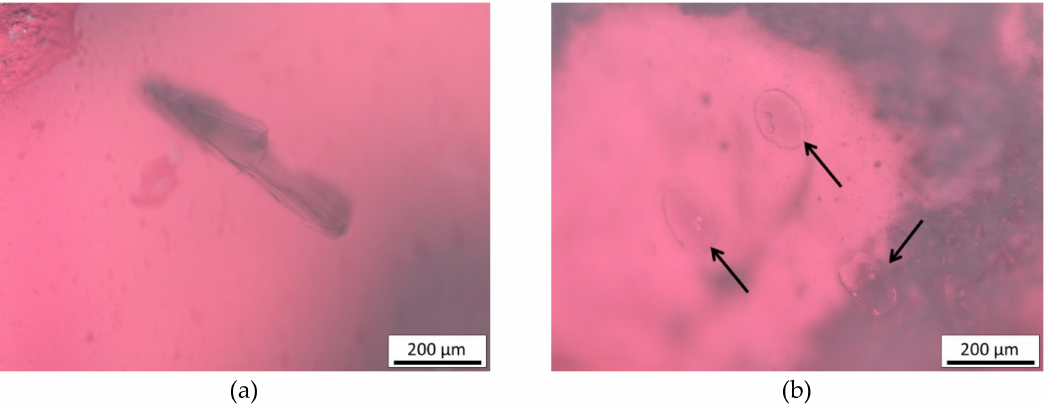
Figure 16. ( a ) Brown plate in garnet G2 of fibula NA89.2 Reflected light, parallel polars; ( b ) Small spherical inclusions in garnet G2 of fibula NA892. Reflected light, parallel